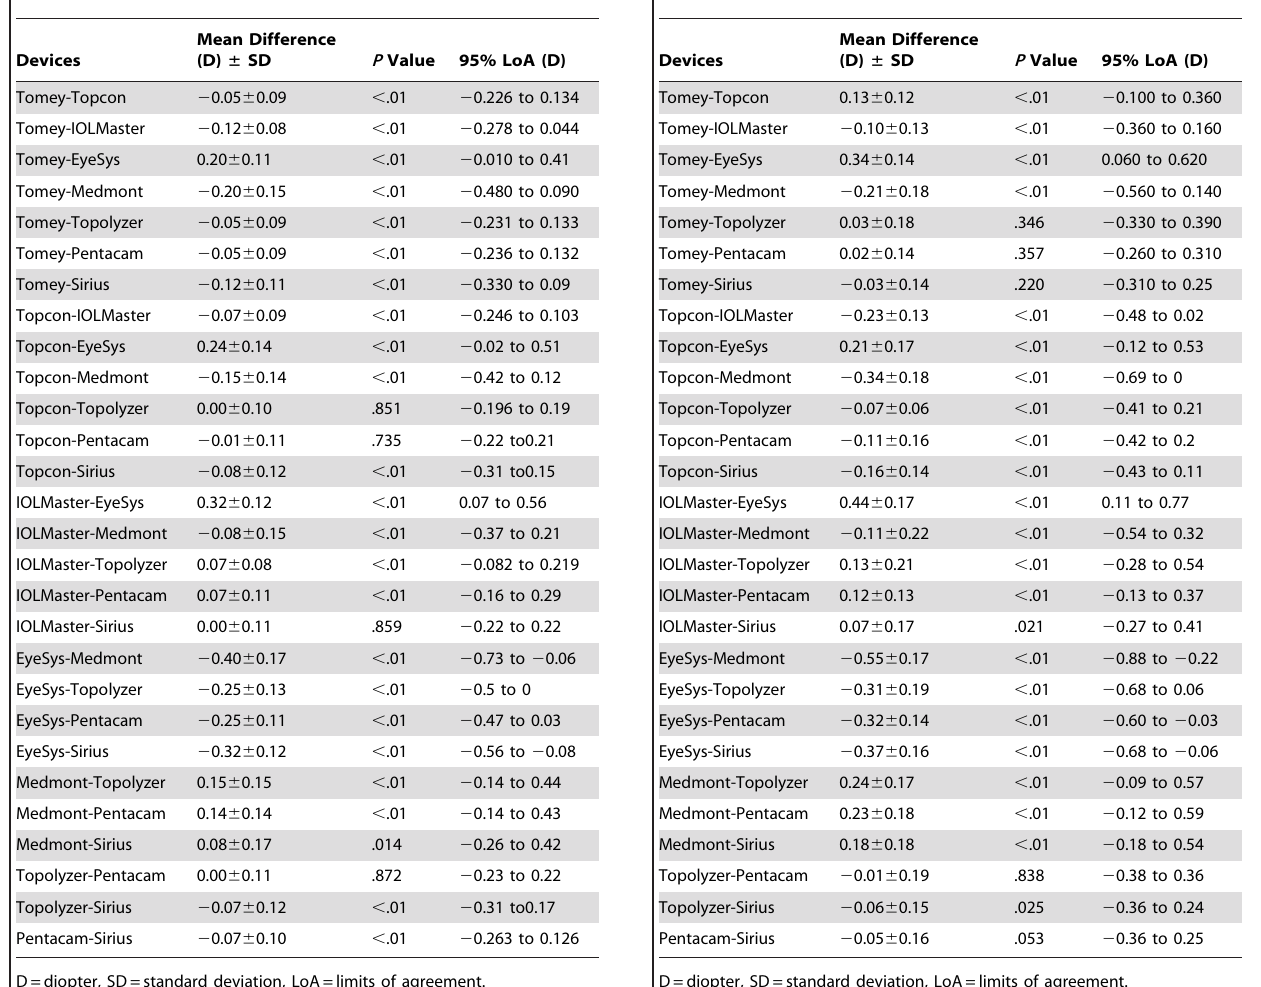
Table 4. Comparison of the Flat Keratometry between 8 Different Devices.